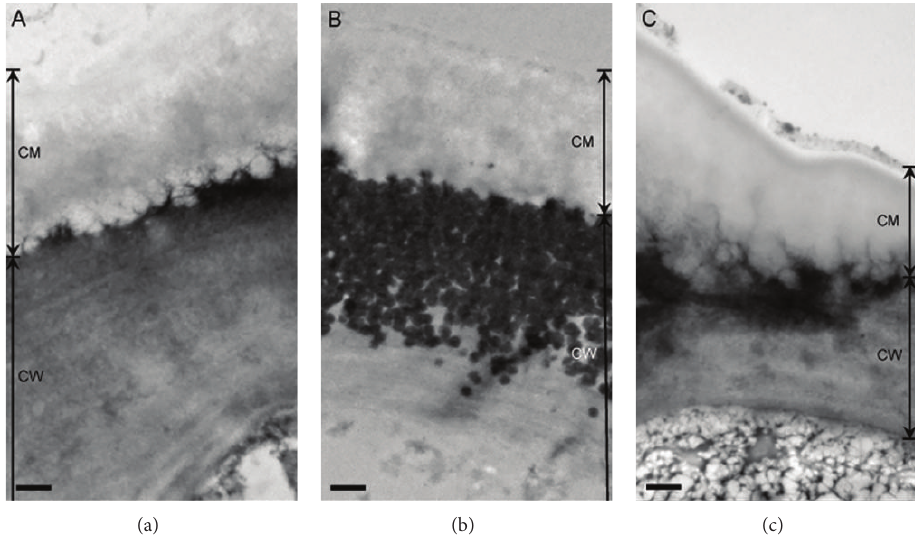
Figure 1: Transversal sections of the adaxial cuticular membrane (CM) and outer cell wall (CW) of intact leaves of eucalypt (a), poplar (b), and pear (c) embedded in LR-White resin. Bars: 500